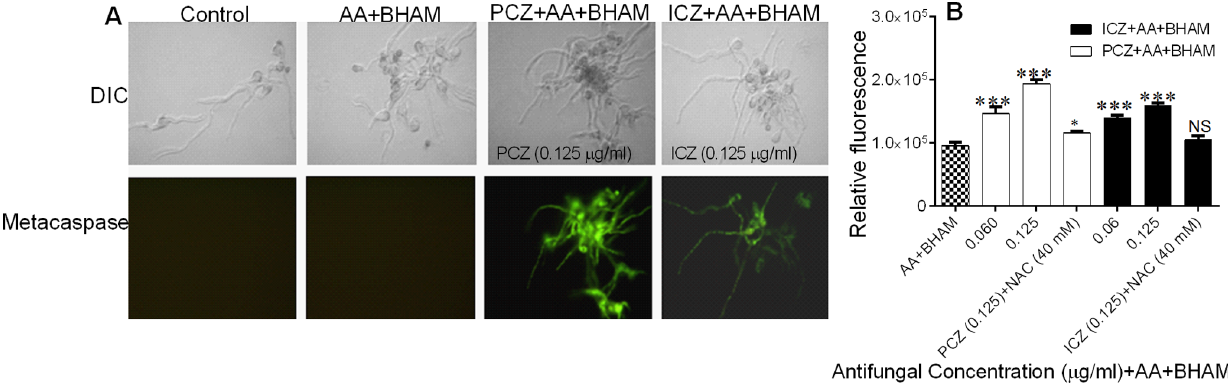
Figure 4. Effect of treatment with PCZ or ICZ in combination with AA and BHAM on caspase-like activity in R.oryzae germlings as determined using FITC-VAD-FMK probe. (A) Caspase-like activity as visualized under a fluorescence microscope. DIC, differential interference contrast. (B) Relative fluorescence of germlings stained with FITC-VAD-FMK. Untreated control cells did not exhibit any fluorescence. ***, p , 0.0001, NS, p . 0.05, compared to AA + BHAM treated